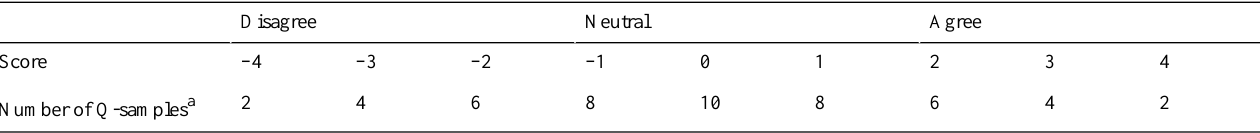
Table 1. Distribution of Q-sorting